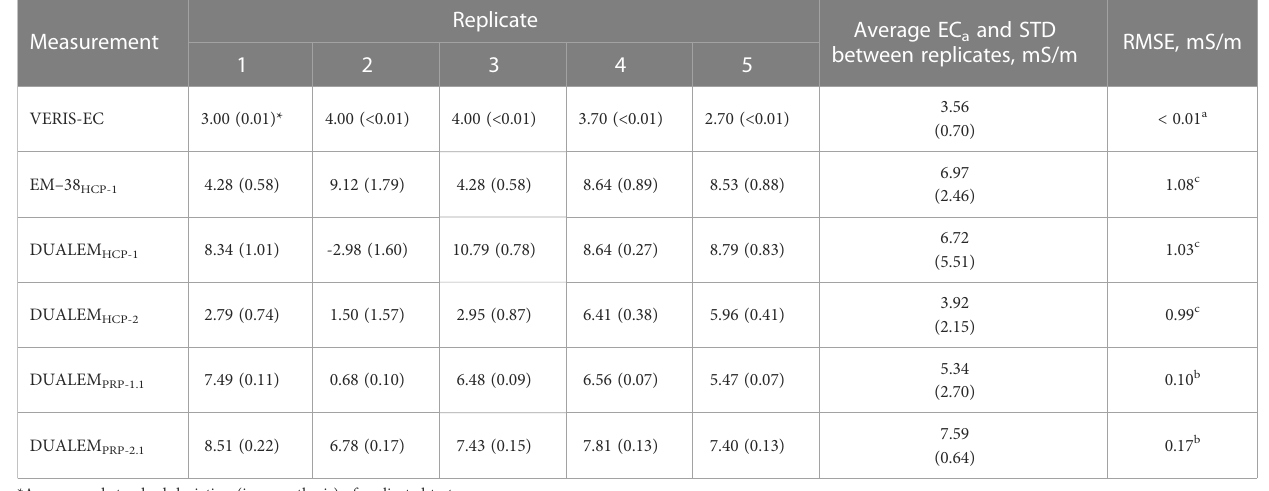
TABLE 4 EC a (mS/m) measurements for temporal tests.